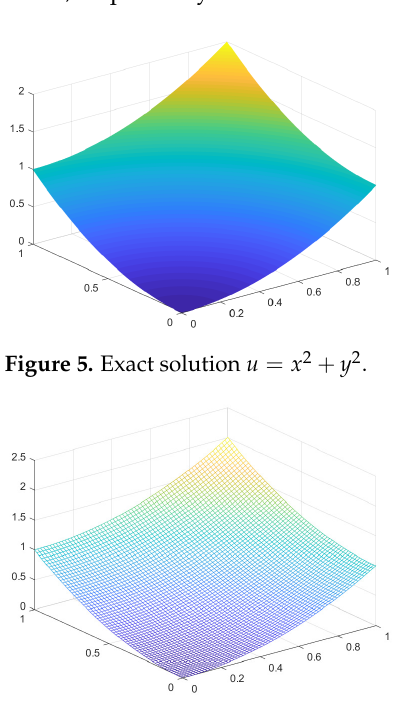
Figure 5. exact solution u = x 2 + y 2 Figure 6. numerical solution u h of B.C. I Figure 6. Numerical solution u h of B.C. I.